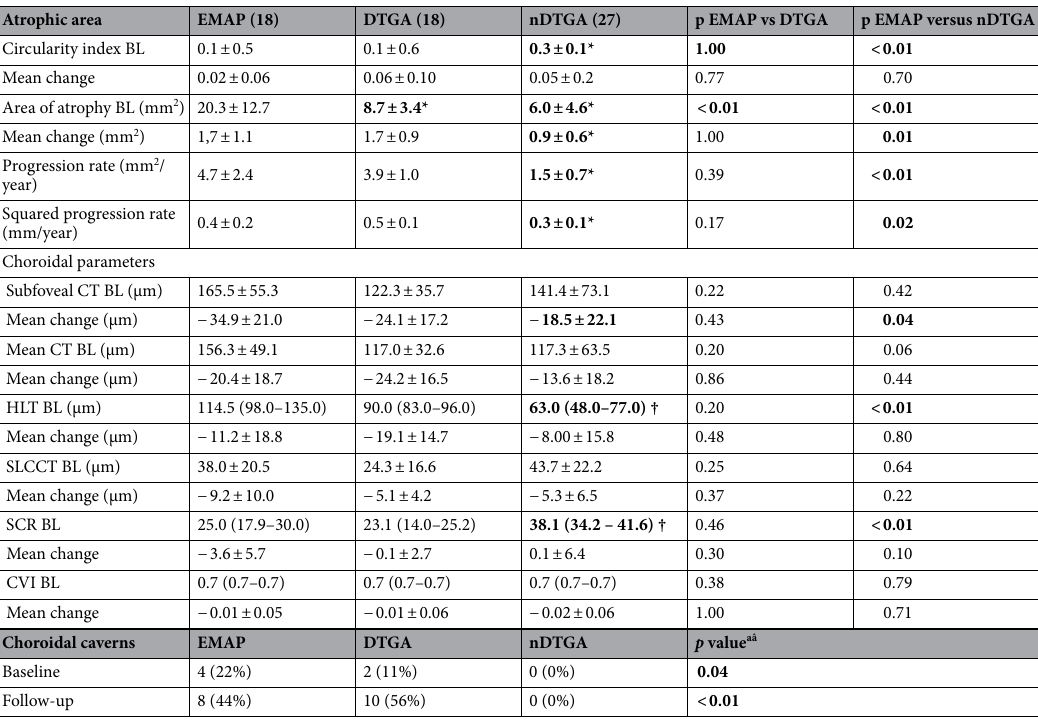
Table 2. Quantitative data of the atrophic area and choroidal parameters. Normally distributed data expressed as mean ± standard deviation. Non-parametric data expressed as Median (Interquartile range 25—Interquartile range 75). Qualitative data expressed as frequency (%). EMAP Extensive macular atrophy with pseudodrusen- like appearance; DTGA Diffuse-trickling geographic atrophy; nDTGA non-diffuse-trickling geographic atrophy; BL Baseline; CT Choroidal Thickness; HLT Haller layer thickness; SLCCT Sattler layer-choriocapillaris thickness; SCR Sattler/Choroid Ratio; CVI Choroidal Vascularity Index. * p < .01 for the comparison with EMAP group using the Tukey HSD post-hoc test for ANOVA. † p < .05 for the comparison with EMAP group using pairwise comparison for Kruskall-Wallis test. a p value for Chi-square test. Significant values are in bold.